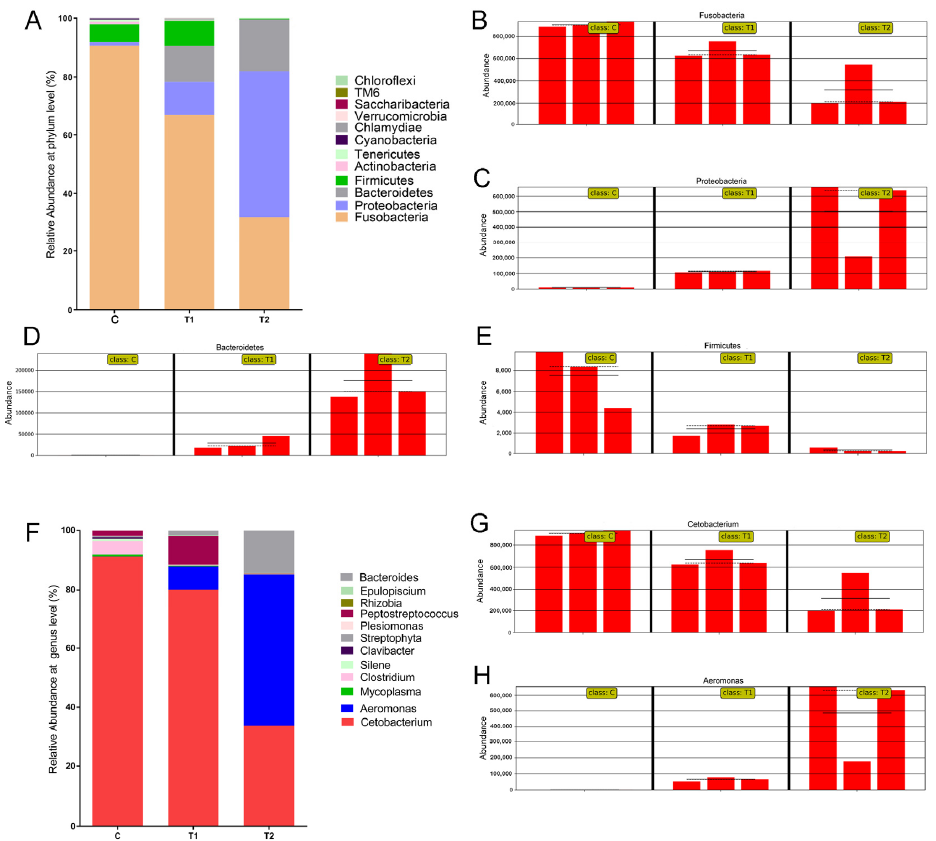
Figure 6. Gut microbiota composition at the phylum level ( A ) and at the genus level ( F ) in gibel carp exposed to aflatoxin B1 for 28 days. ( B – E ) Partial phyla with significant changes in relative abundance among treatment groups. ( G , H ) Partial genera with significant changes in relative abundance among treatment groups. C: control diet, T1: 50 µg/kg AFB1, T2: 100 µg/kg AFB1.